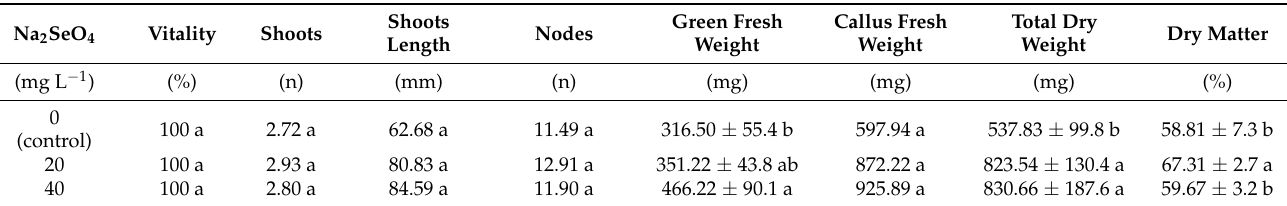
Table 1. Average values of the three subcultures for proliferated explants of the ‘San Felice’ cv. Na 2 SeO 4